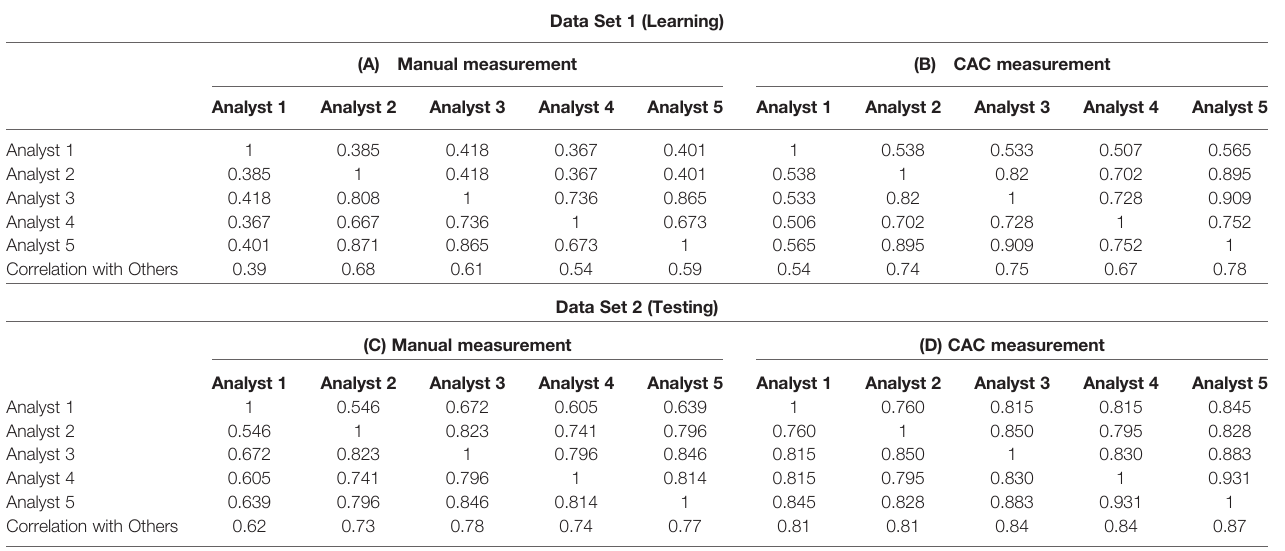
TABLE 2 | Pearson correlation matrix among fi ve image analysts in data sets 1 and 2.